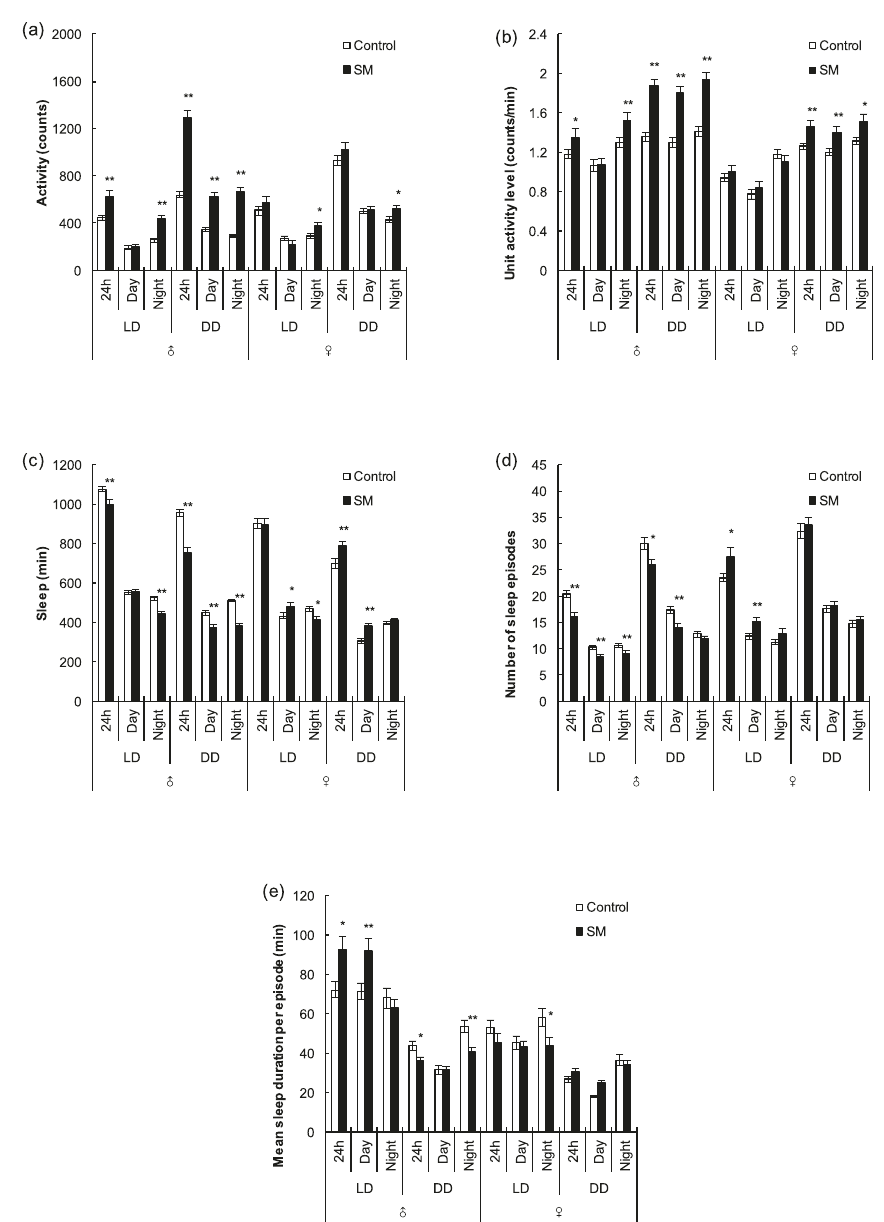
Fig. 2 Activity and sleep of Canton-S male and female fruit fl ies under simulated microgravity under LD and DD conditions. a Total activity. b Unit activity level. c Total sleep time. d Number of sleep episodes. e Mean sleep duration per episode. Data were calculated by mean of 3 days. White and black boxes represent data for the control and simulated microgravity fruit fl ies, respectively. n ⫺ 90. * P < 0.05, ** P < 0.01. Error bars represent standard